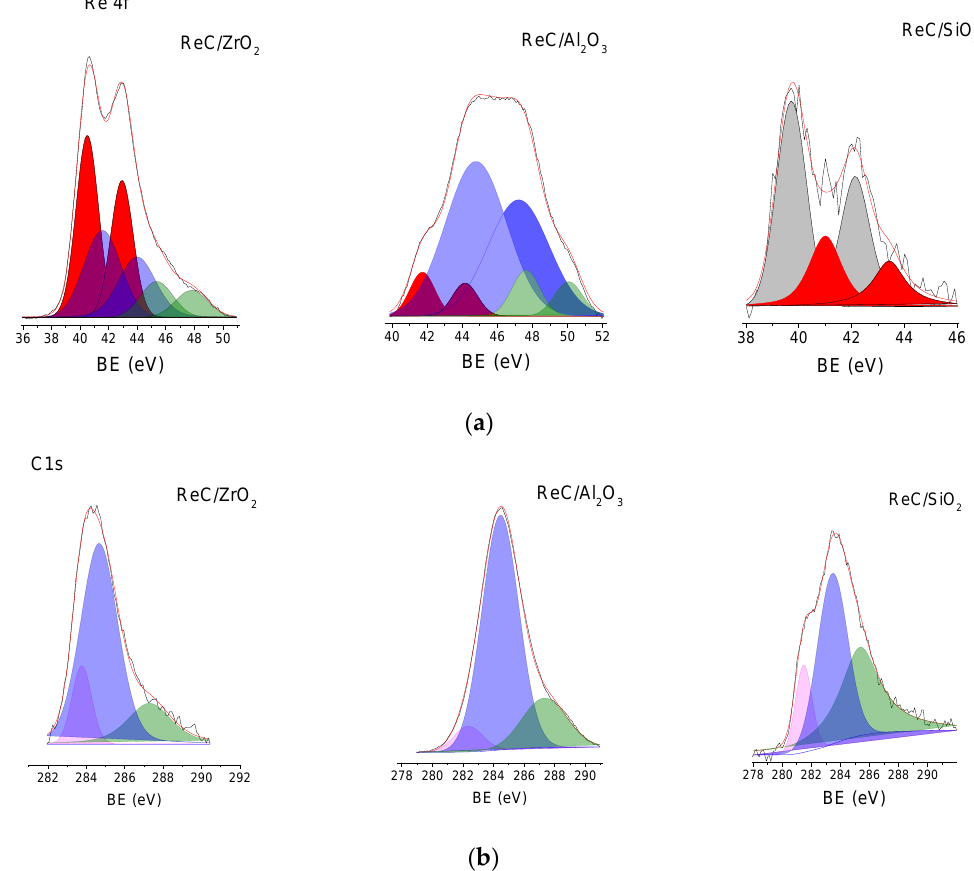
Figure 3. XPS deconvolution of the Re 4f ( a ) and C 1s ( b ) component. Table 2. XPS data obtained for the catalysts after in situ re-reduction at 350 °C BE, eV (%) Catalyst Re 4f 7/2 C 1s Re 0